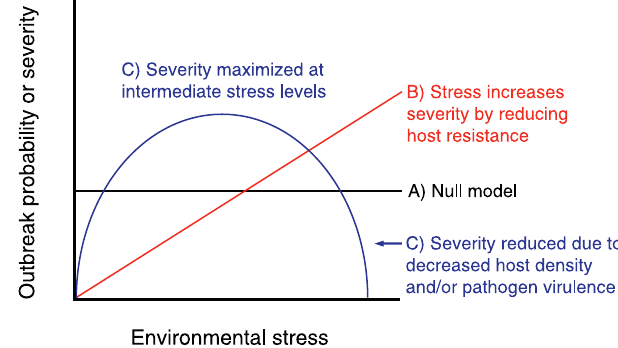
Figure 3. Predicted Effects of Environmental Stress on Disease Severity Conceptual model of potential effects of environmental stress (magni- tude or frequency) on the probability or severity (e.g., prevalence or impacts on host populations) of disease outbreaks. The model includes three possible scenarios: (A) the null model of no effect, (B) a positive, linear effect of stress such as when host density is unrelated to incidence and when the pathogen is not negatively affected by the stress, and (C) a parabolic stress effect.